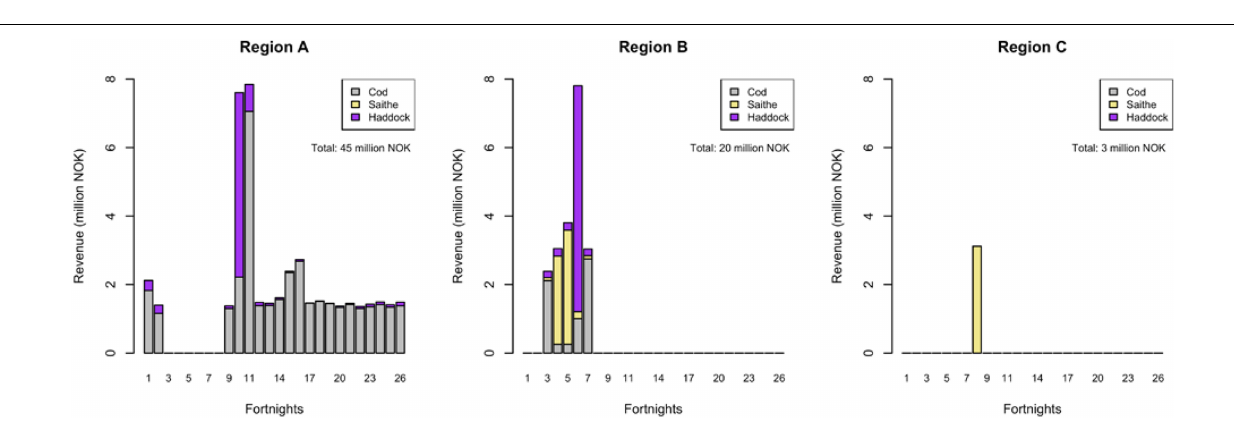
FIGURE 9 | Maximum annual fishing revenue from the holding quota portfolio of the cod, saithe, and haddock fisheries decomposed into the three selected regions. The revenue shares of regions A, B, and C are 45, 20, and 3 million kroner (NOK),